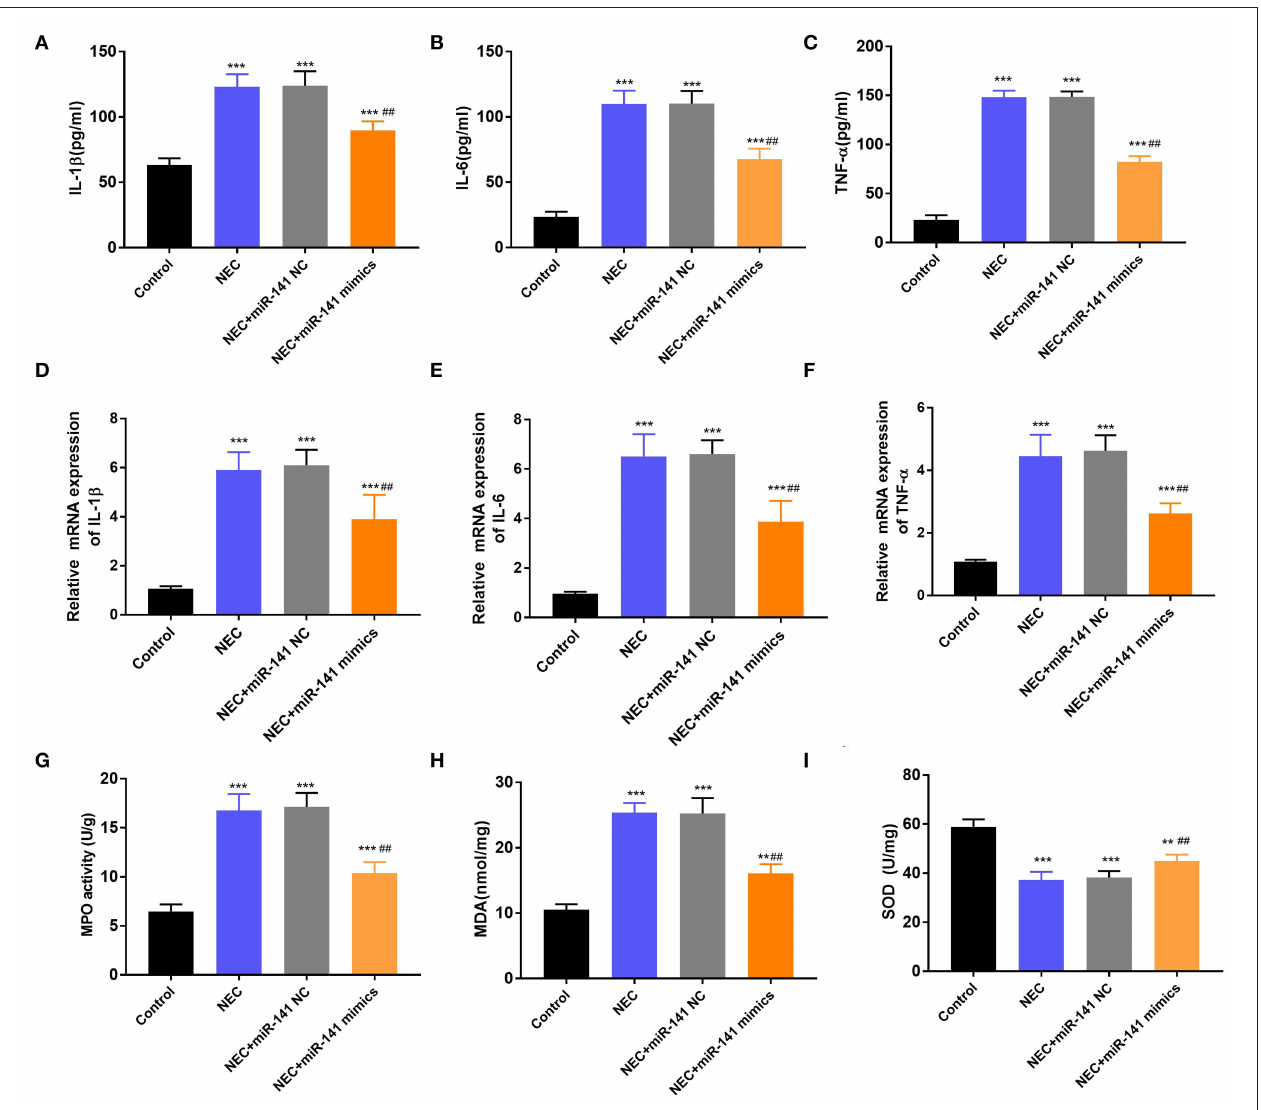
FIGURE 3 | MiR-141-3p regulated the inflammation response and oxidative stress damage in NEC. After establishment of the NEC model and transfection with miR-141 mimics/miR-141 NC vectors, the concentrations of (A) IL-1 β , (B) IL-6, and (C) TNF- α were assayed via ELISA; the mRNA expression of (D) IL-1 β , (E) IL-6, and (F) TNF- α were examined via RT-qPCR; (G) the MPO activity, the levels of (H) MDA and (I) SOD were evaluated via the corresponding kits. ** P < 0.01, *** P < 0.001 in comparison with the Control group; ## P < 0.01 in comparison with the NEC group or NEC + miR-141 NC.